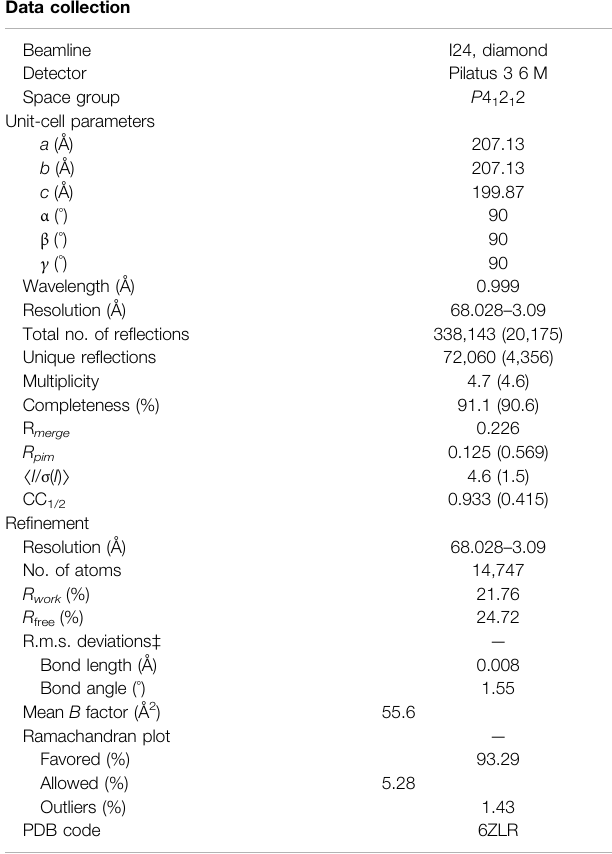
TABLE 1 | Values in parentheses are for the highest resolution bin. Data